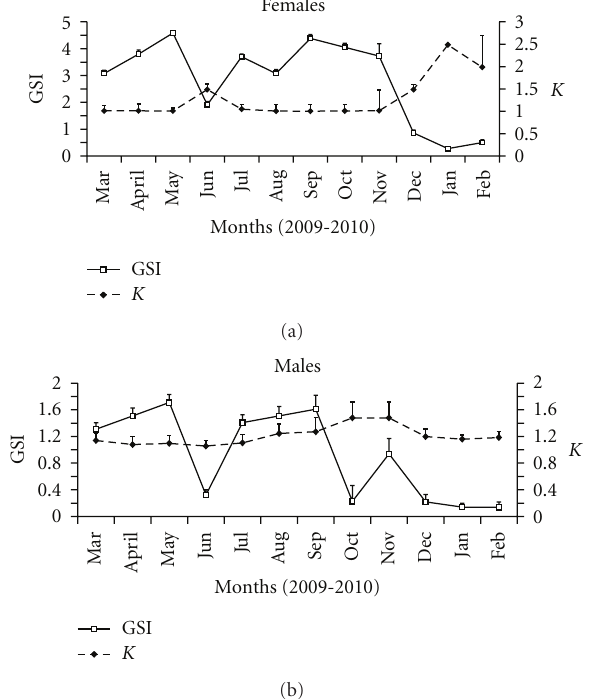
Figure 8: (a) Relationship between the GSI and K of C. menezesi (a) females and (b)